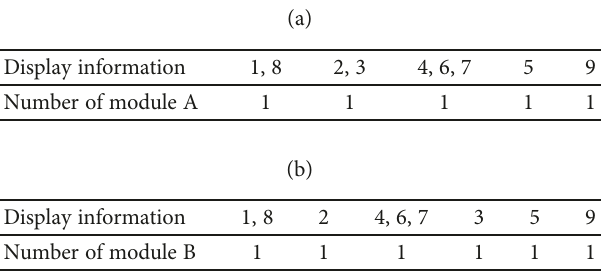
Table 3: Resource con fi guration of display function of